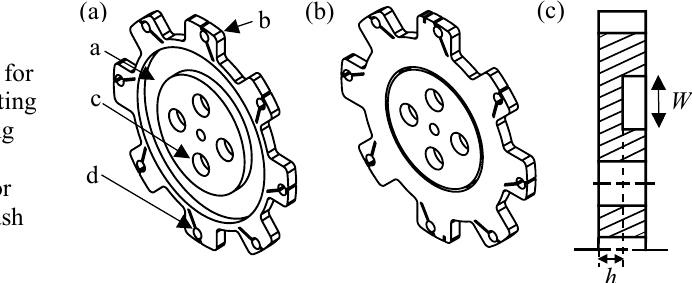
Figure 3 : In-plane torsional specimen: (a) Obverse face of wide gauge section with key features labelled, (b) Obverse face of narrow gauge section, and (c) Top half of section view with gauge section dimensions